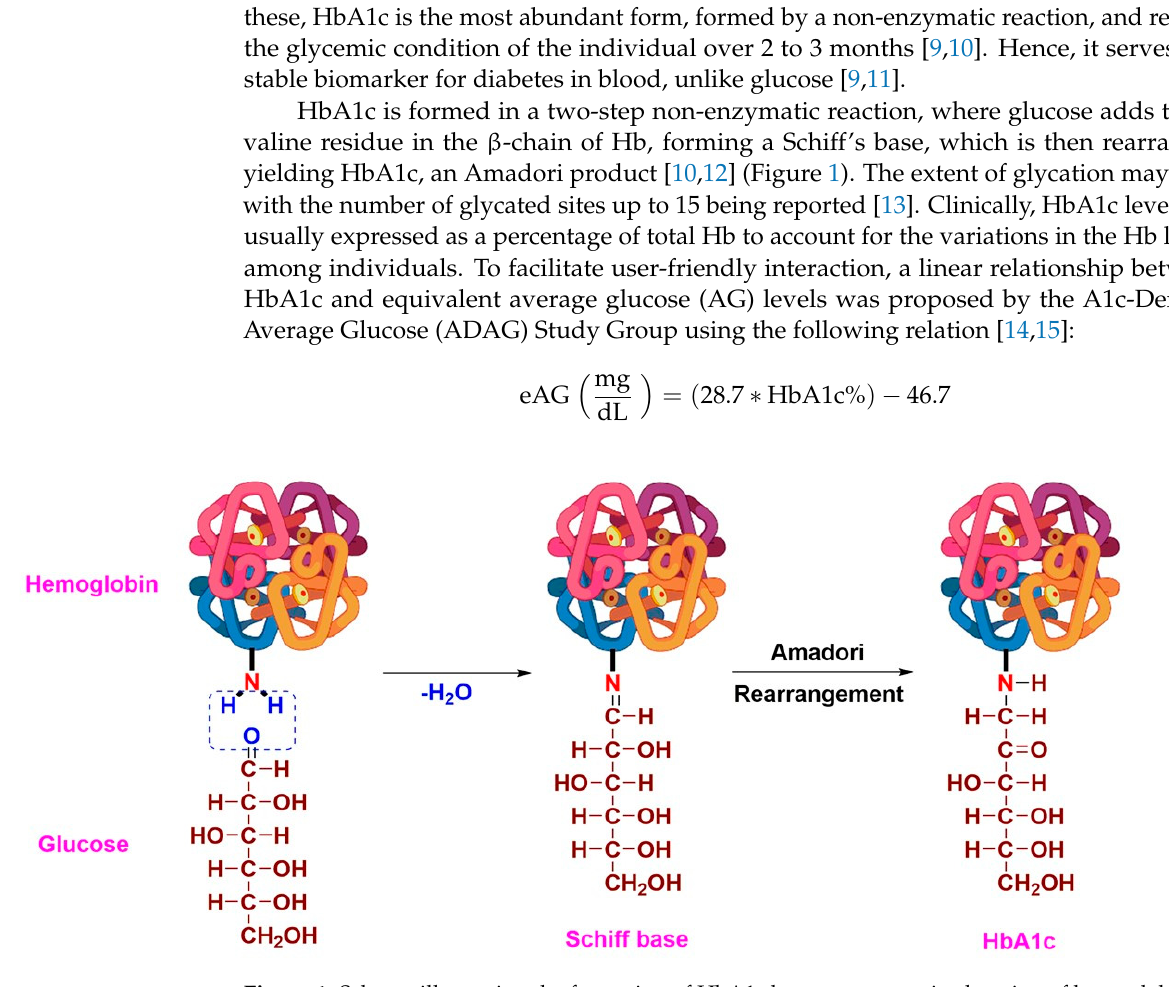
Figure 1. Scheme illustrating the formation of HbA1c by non-enzymatic glycation of hemoglobin via Amadori rearrangement.